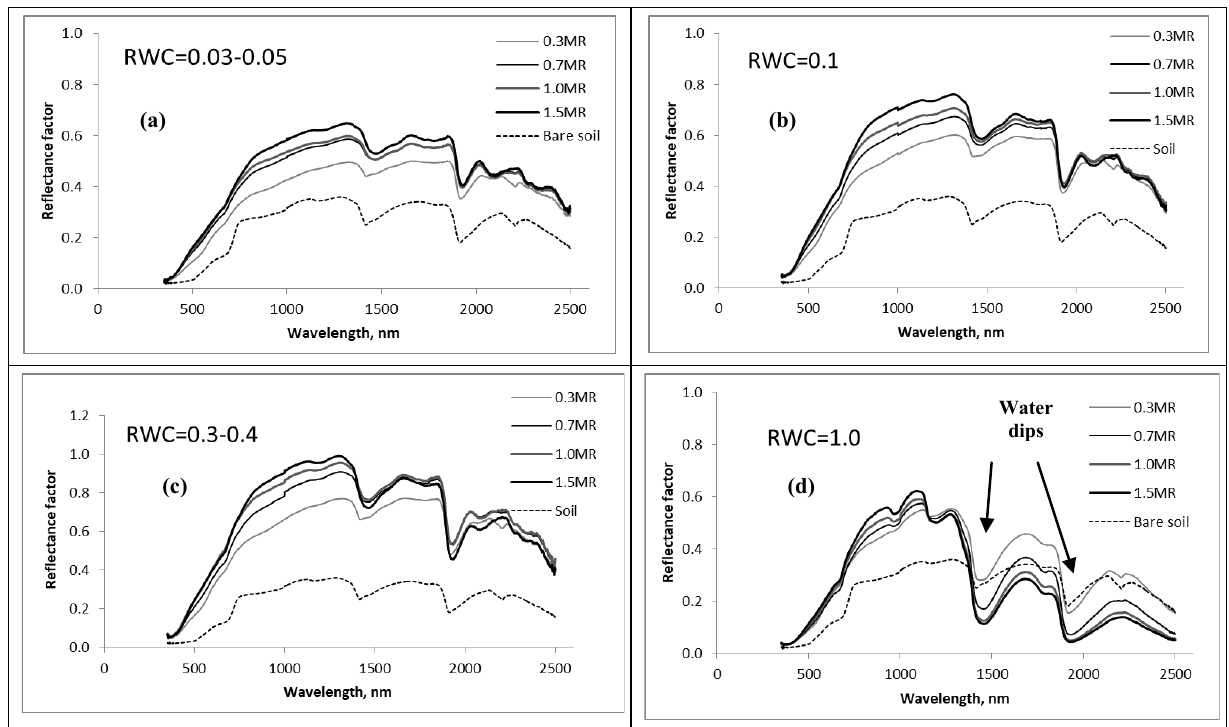
Figure 4 Reflectance spectra for different mass of rice residue placed over red soil for (a) RWC=0.03-0.05 (dry) (b)